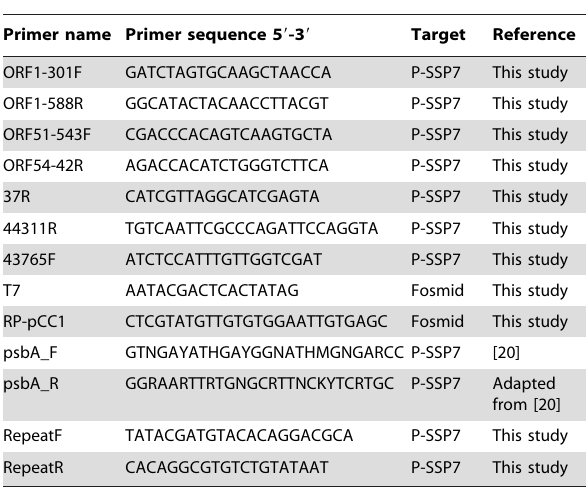
Table 1. PCR and sequencing primers used in this